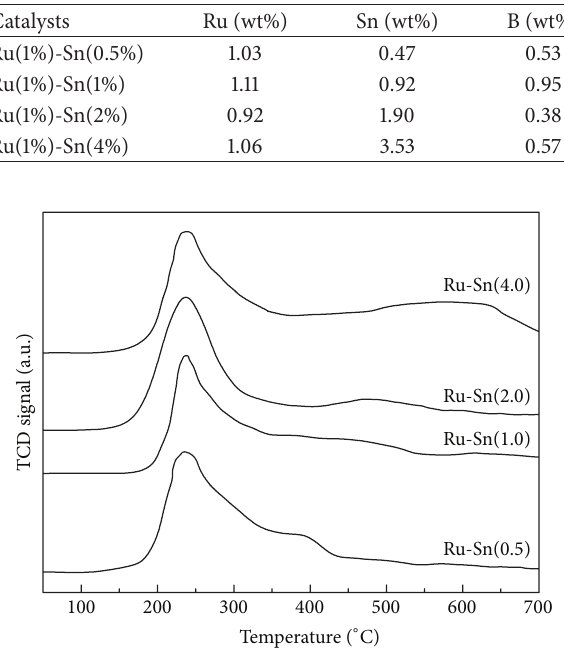
Figure 1: Bimetallic catalysts. Temperature programmed reduction results.